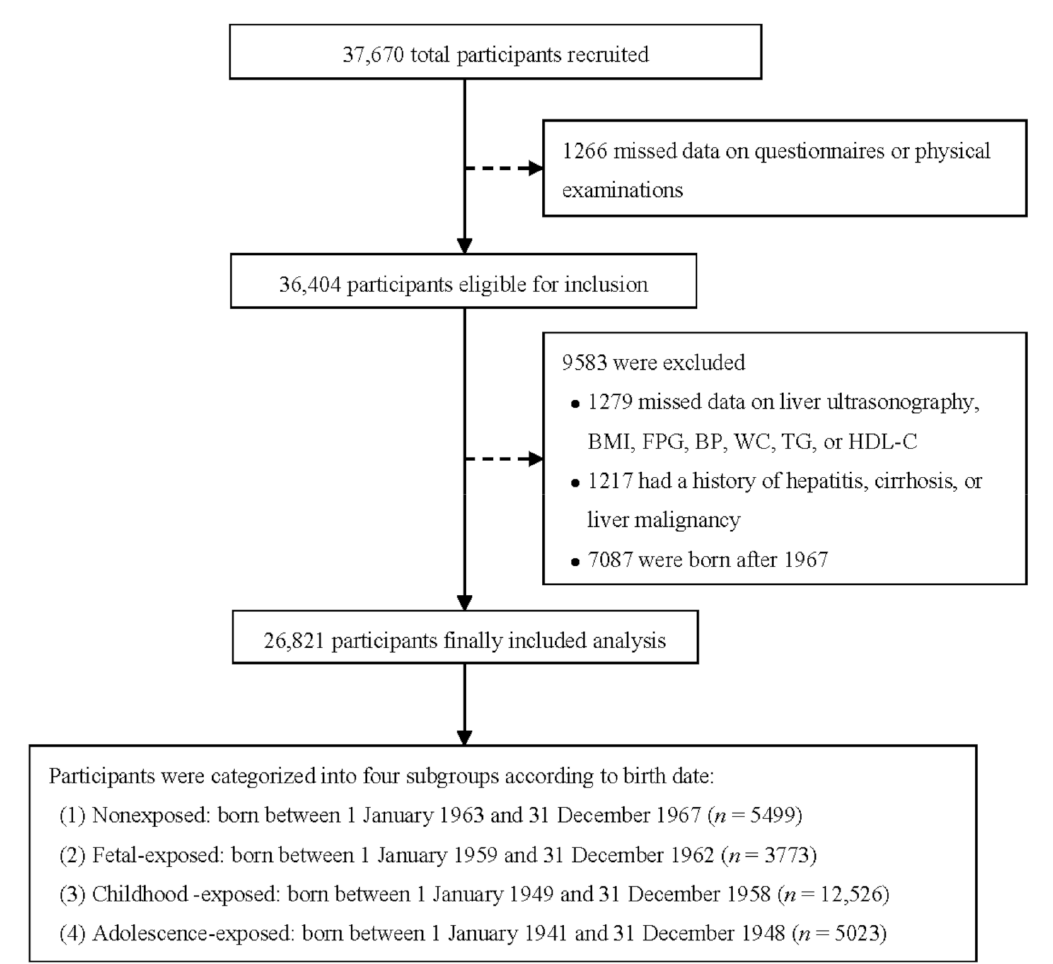
Figure 1. Flow chart of study participants. BMI, body mass index; BP, blood pressure; FPG, fasting plasma glucose; HDL-C, high-density lipoprotein cholesterol; TG, triglycerides; WC, waist